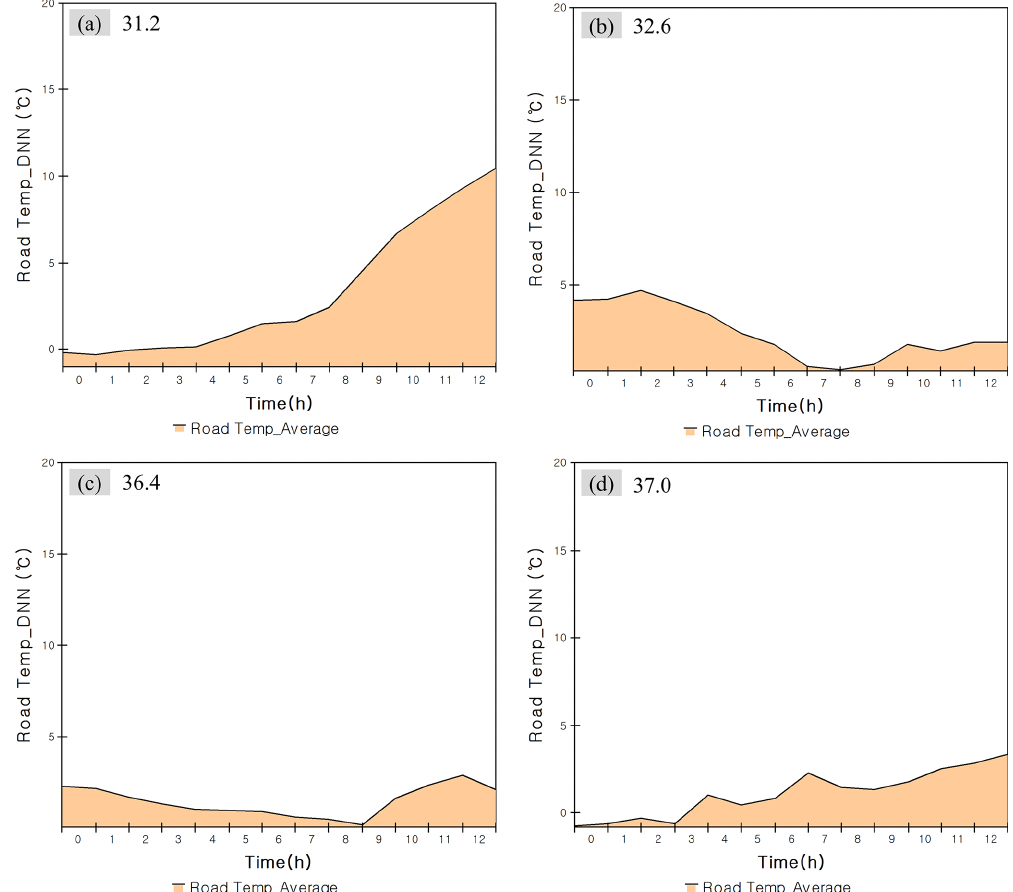
Figure 7. Road temperature prediction results by system dynamics and DNN. (a) Prediction of road temperature for 16 December. (b) Pre- diction of road temperature for 17 December. (c) Prediction of road temperature for 18 December. (d) Prediction of road temperature for 19